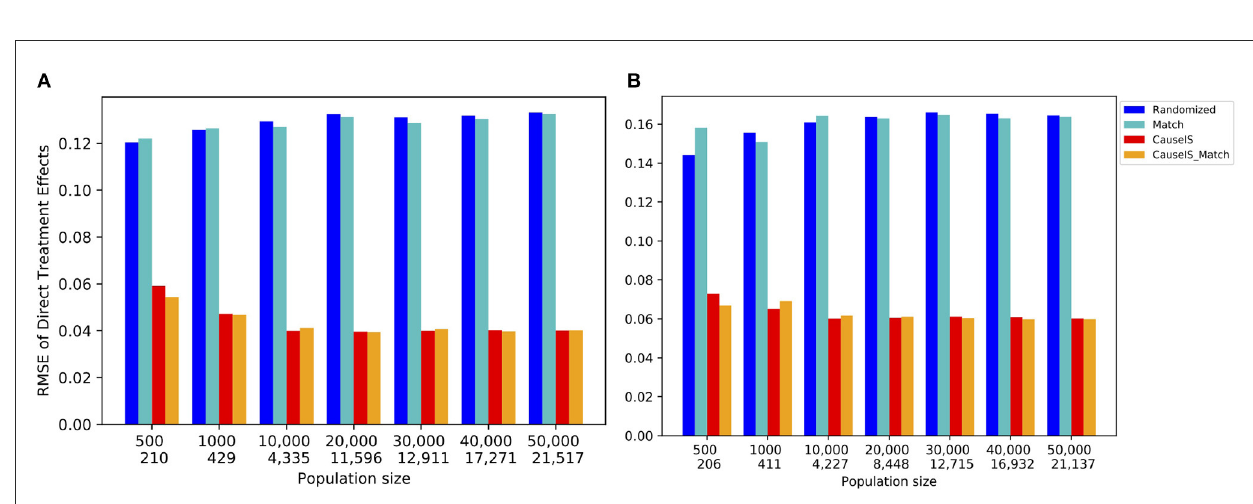
FIGURE5 RMSE of direct treatment effect in synthetic data with a different number of nodes and edges. Numbers in the first row of the x-axis show the number of nodes in graphs, and the second row represents the size of MIS. (A) Forest Fire model. (B) Barab’asi-Albert